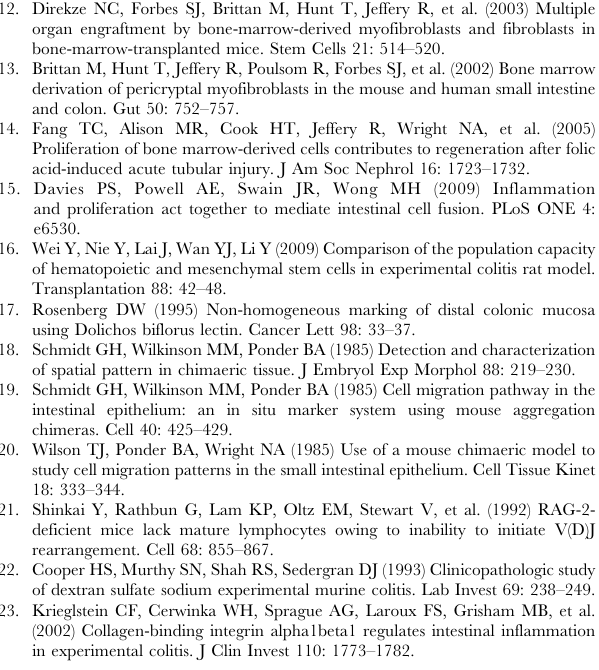
Table S1 DBA Lectin stains Rag-2 gut epithelium and SWR blood vessel endothelium. CD45 (leukocyte common antigen, LCA) stains all lymphoid lineages from BM. a -smooth muscle actin stains pericryptal or other myofibroblasts, plus